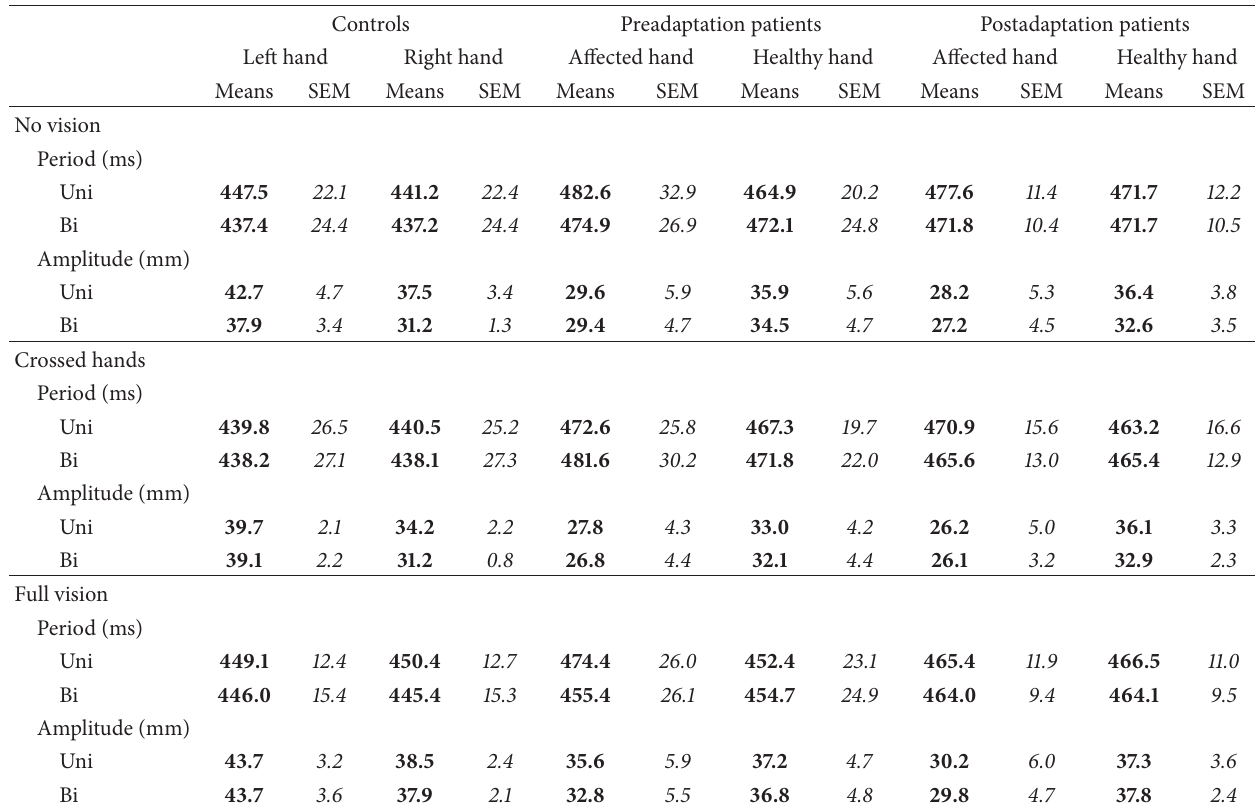
Table 3: Data description for finger tapping task for controls and patients, before and after adaptation. Controls Preadaptation patients Postadaptation patients Affected hand Healthy